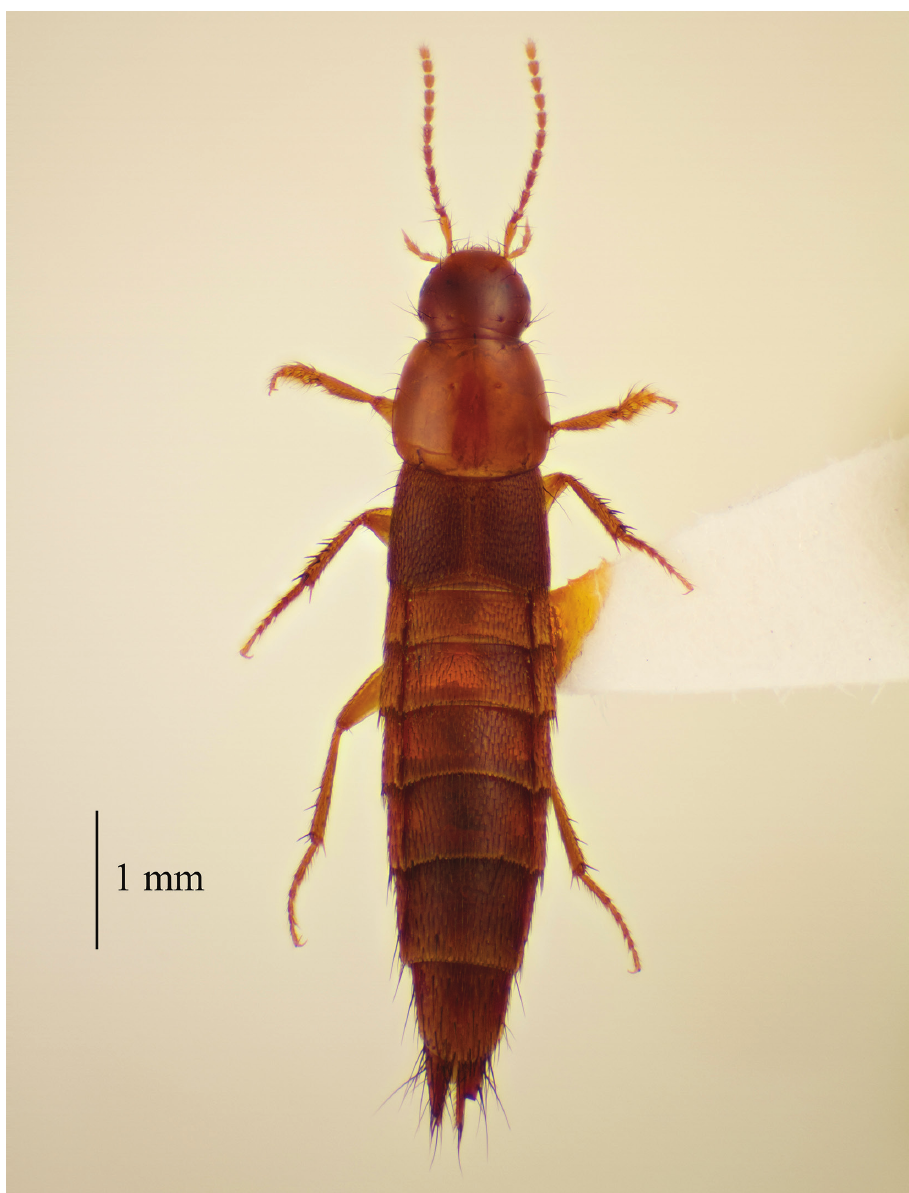
Figure 4. Habitus of Quediopsis howensis Jenkins Shaw & Solodovnikov, sp. n.